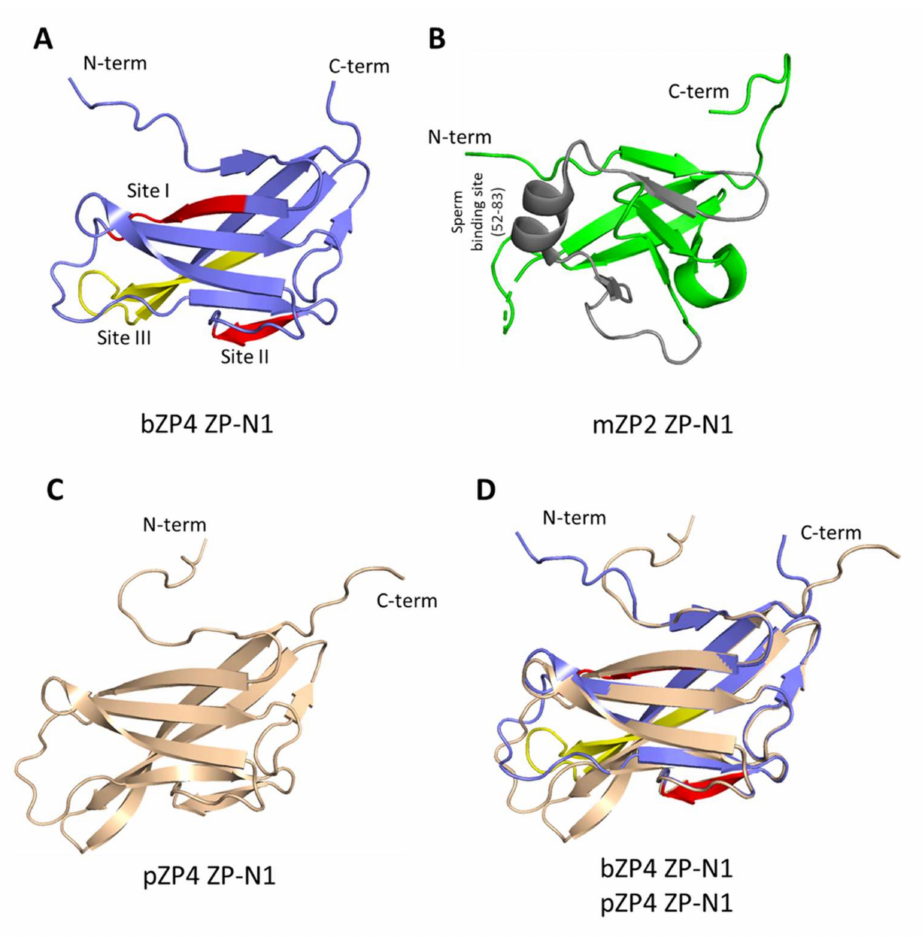
Figure 6. Structural comparison among N-terminal ZP-N1 domains of mouse (m)ZP2, bovine (b)ZP4 and porcine (p)ZP4. ( A ) A predicted structural model of the ZP-N1 domain of bZP4. The model was made using AlphaFold2 [28]. Three sperm-binding sites proposed in the present study are highlighted in red (Sites I and II) and in yellow (Site III). ( B ) Crystal structure of the N-terminal ZP-N1 domain of mZP2 (PDB 5II6) [27]. Mouse sperm-binding region is highlighted in gray. ( C )